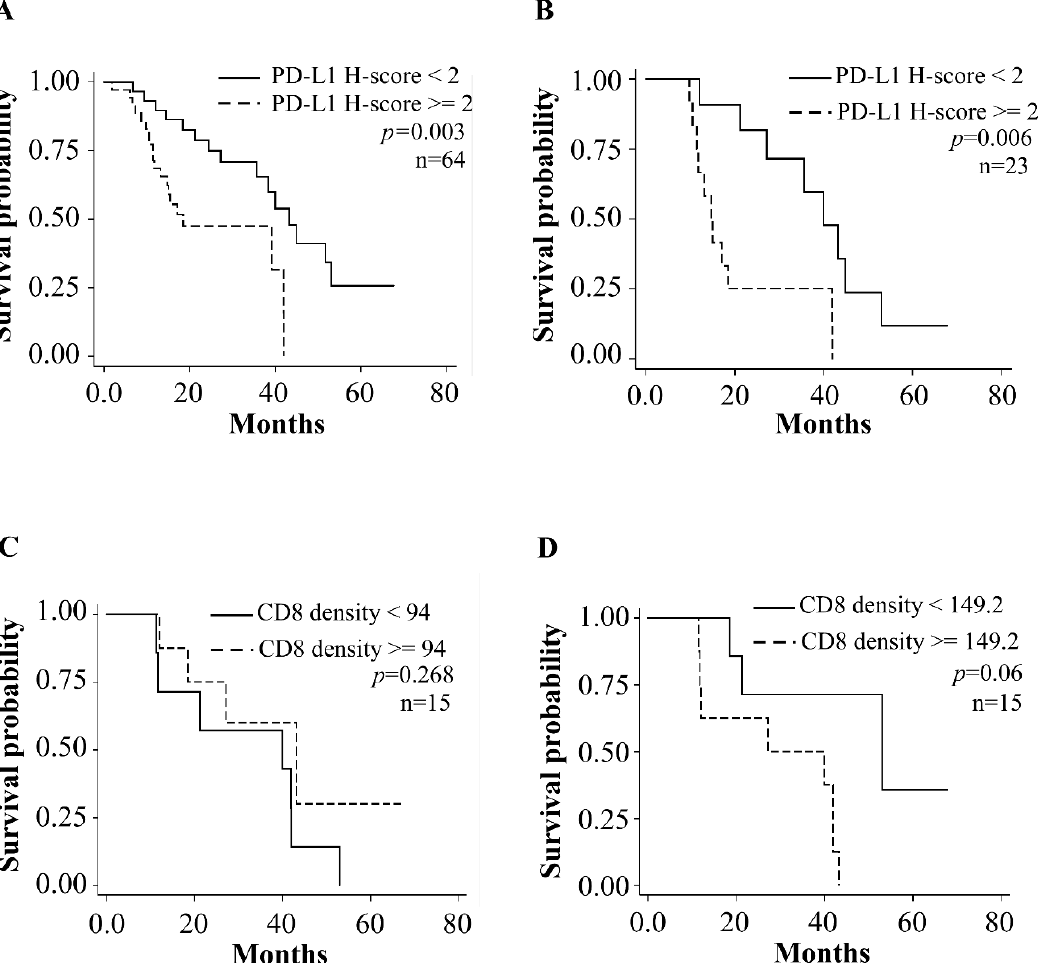
Figure 3. Kaplan–Meier survival curves dichotomized by the median of PD-L1 and CD8 H-score in ESCC specimens. ( A ) Patients with high pre-CCRT PD-L1 H-score had significantly worse overall survival in all patients (n = 64, p = 0.003); ( B ) in patients with paired specimens (n = 23, p = 0.006); ( C ) pre-CCRT CD-8 was not associated with patient survival (n = 15, p = 0.268); ( D ) patients with lower post-CCRT CD8 had borderline better survival (n = 15, p = 0.06).